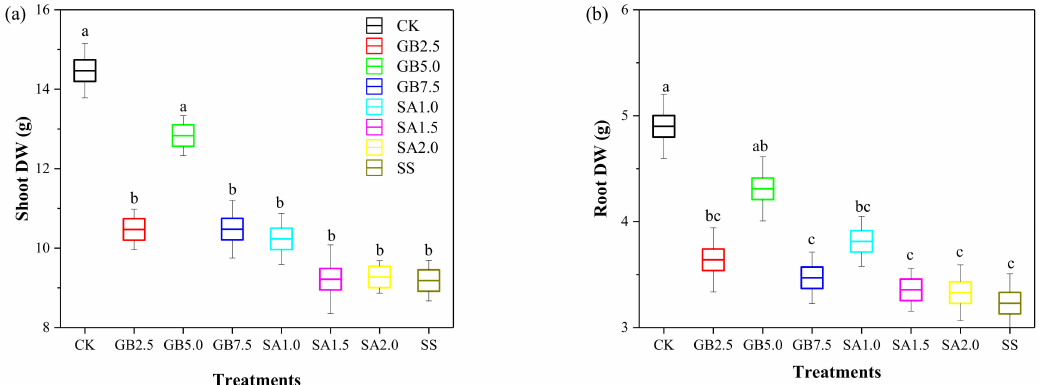
Figure 2. Effect of exogenous glycine betaine (GB) and salicylic acid (SA) on ( a ) shoot dry weight (DW) and ( b ) root dry weight (DW) of 150 mM NaCl-stressed seedlings. Treatments: CK, control; GB2.5, 2.5 mM GB; GB5.0, 5.0 mM GB; GB7.5, 7.5 mM GB; SA1.0, 1.0 mM SA; SA1.5, 1.5 mM SA; SA2.0, 2.0 mM SA; SS, salt stress (150 mM) without supplementation. Values are means ± standard deviation (n = 3). Different letters represent significant differences between the treatments at p < 0.05.